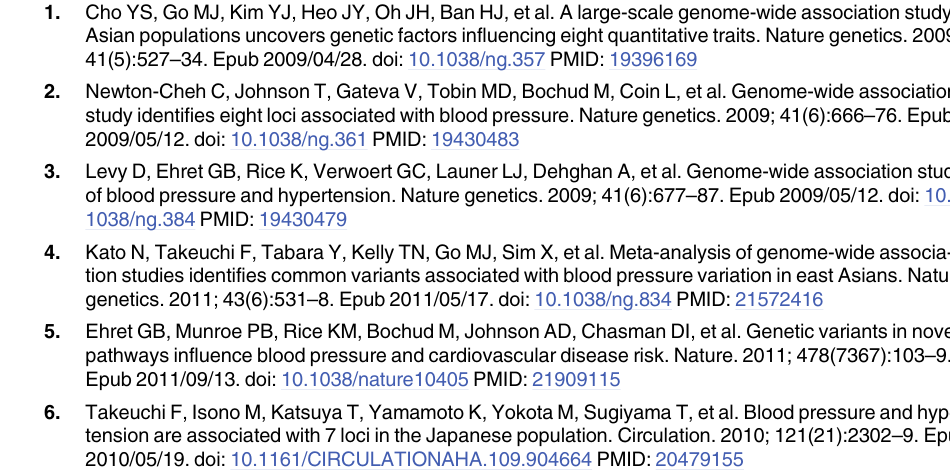
S4 Table. Reduction of Csk , Ulk3 , and Cyp1a2 mRNA levels in cells after treatment with siRNAs. S5 Table. Primers used for quantitative real-time